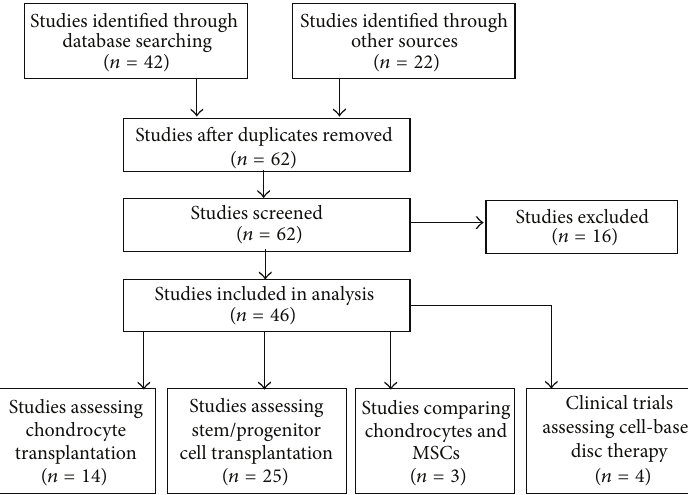
Figure 1: Flow diagram demonstrating the systematic analysis